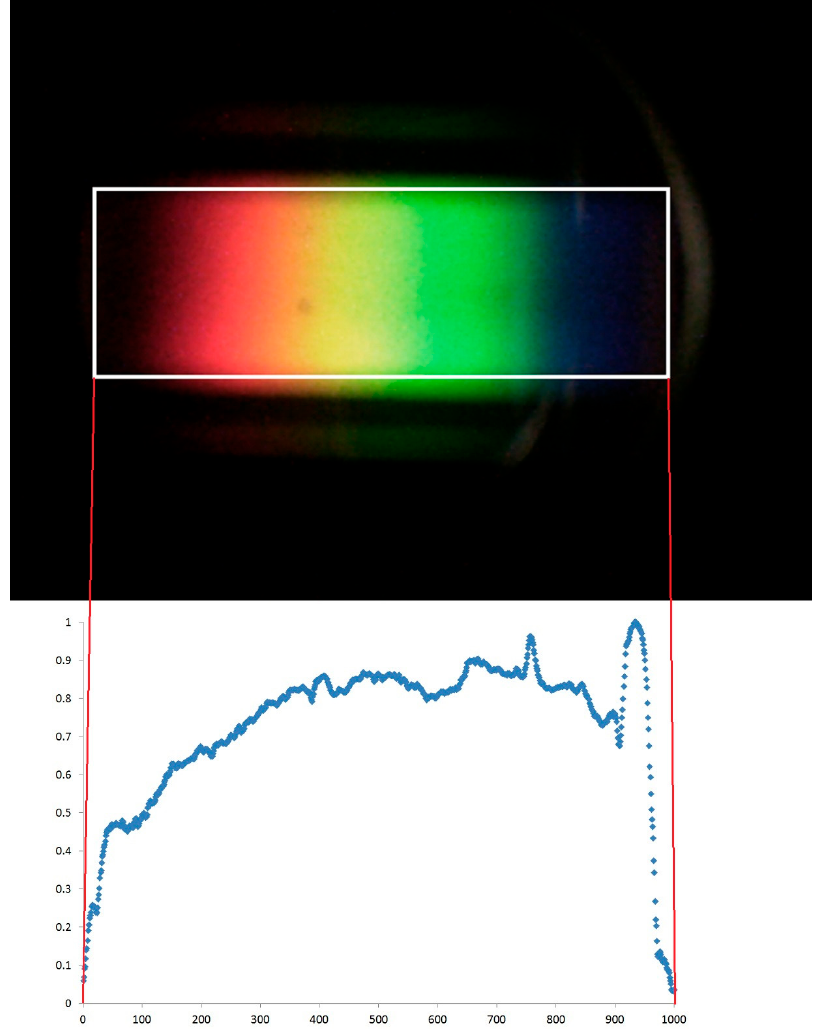
Figure 3. A schematic demonstrating the conversion of the photograph captured by PHYLIS into a spectrum.